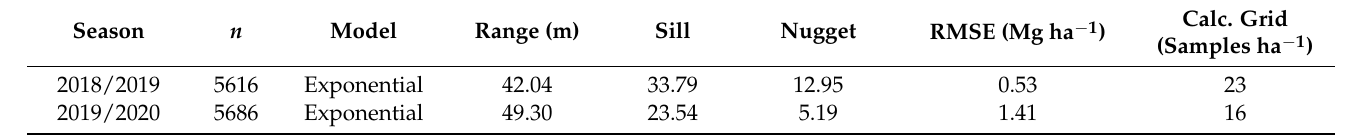
Table 5. Fitted model and semi-variogram variables used to interpolate sugarcane yield